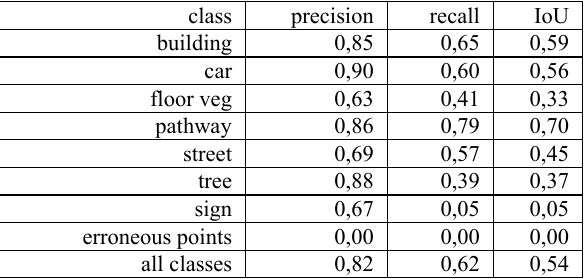
Table 1: Investigate the performance of the PCCT with a